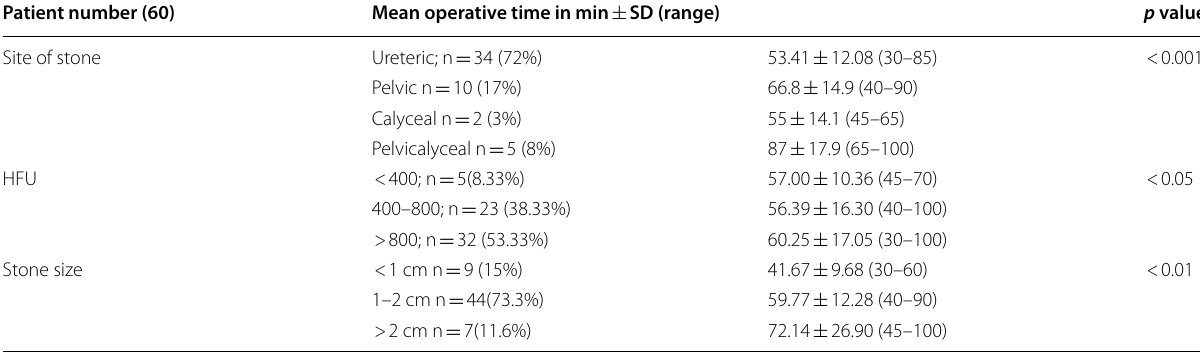
Table 6 Comparison between operative time and stone size, site, HFU